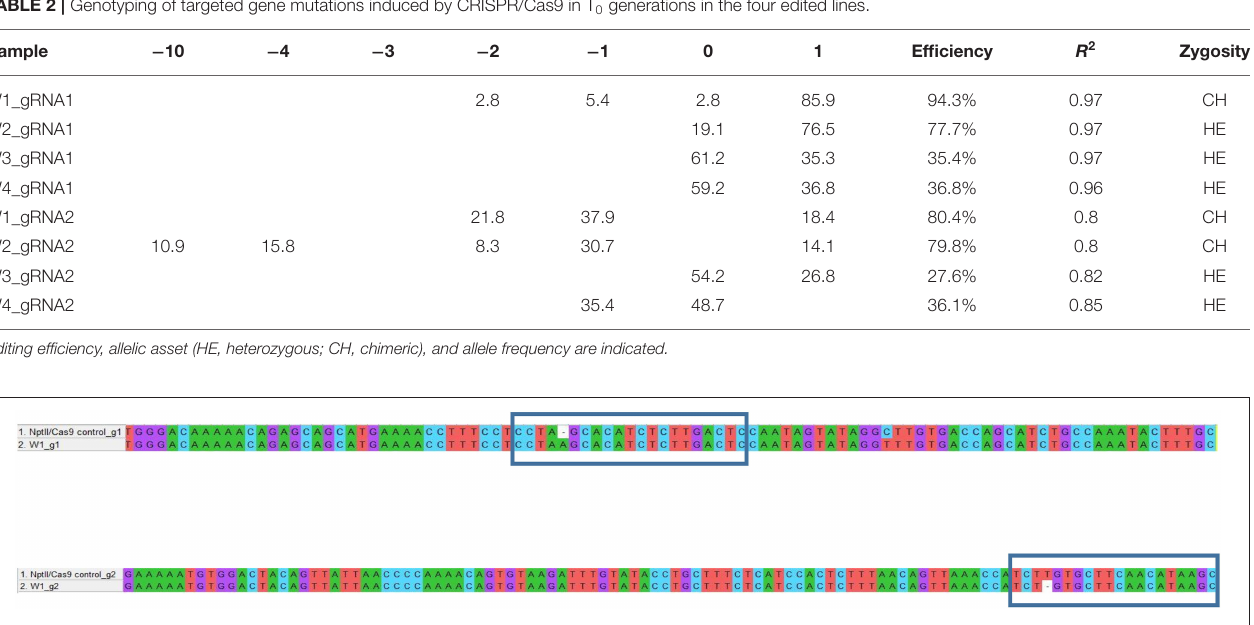
FIGURE 5 | Example of genotyping of targeted gene mutations induced by CRISPR/Cas9 in the W1 line. The blue box underlines the gRNA sequences. When compared with nptII/Cas9 control, the W1 line showed a nucleotide insertion at gRNA1 level and a nucleotide deletion at gRNA2 level.